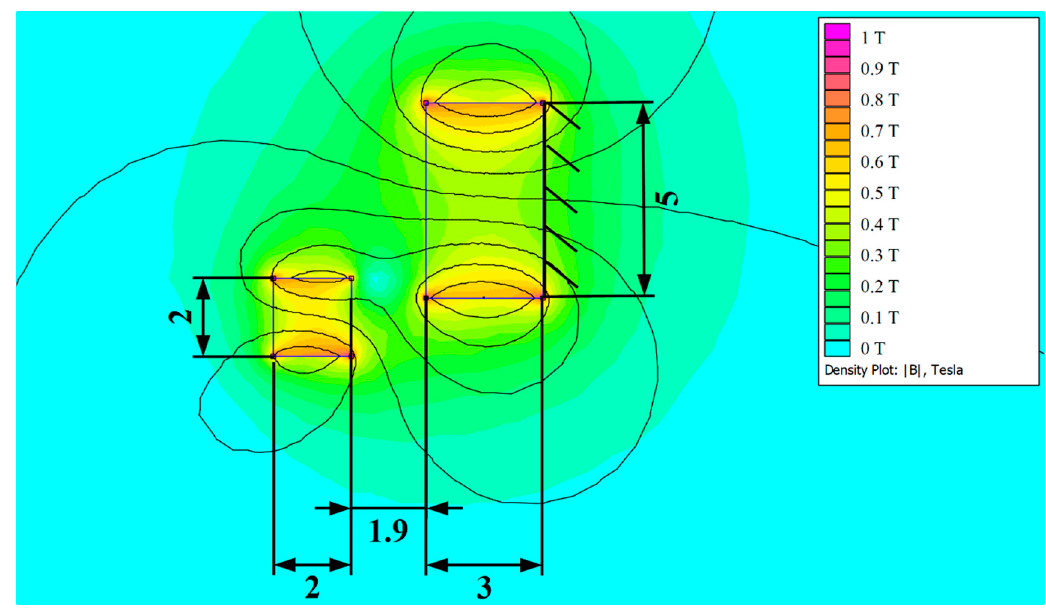
Figure 10. Final design of the Auxiliary Magnetic System; dimensions are in (mm). The depth is 10 mm.